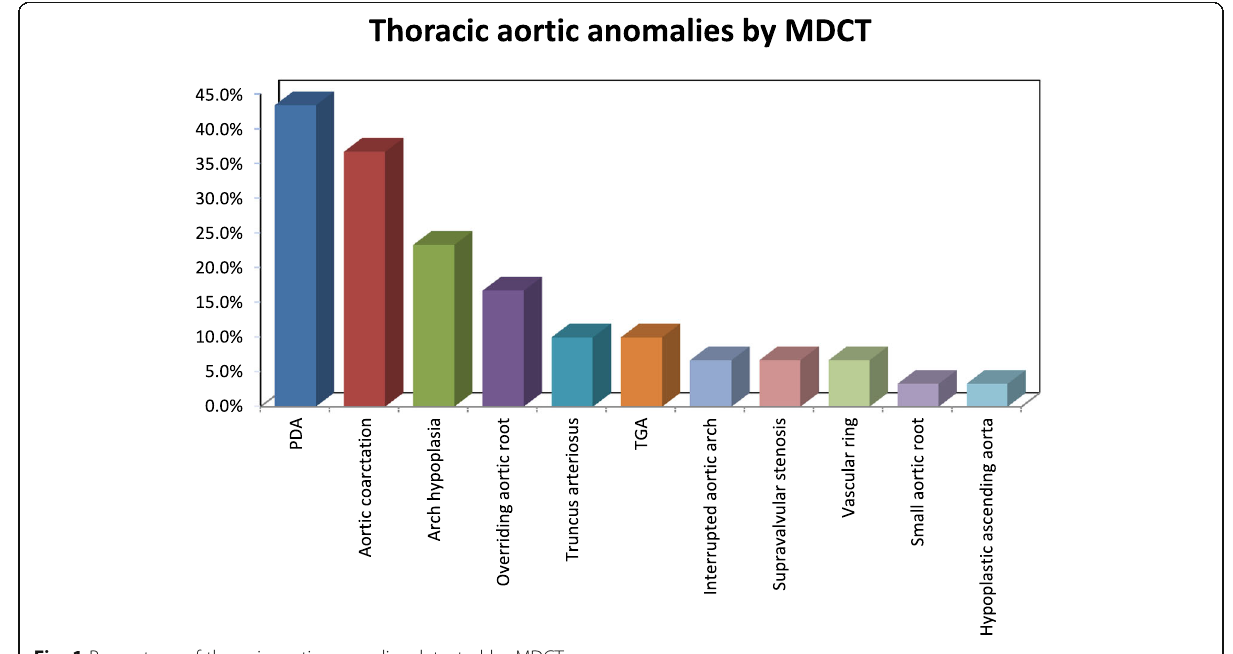
Fig. 1 Percentage of thoracic aortic anomalies detected by